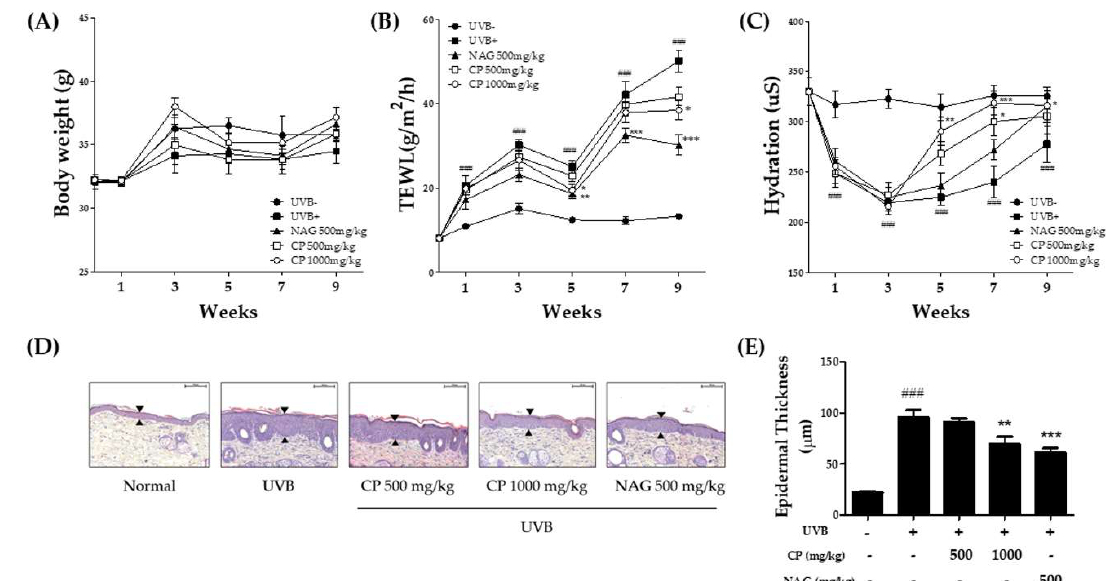
Figure 1. Effect of oral administration of collagen peptide on TEWL, hydration, and epidermal thickness in the dorsal skin of UVB-irradiated hairless mice. ( A ) Body weight changes, ( B ) TEWL, and ( C ) stratum corneum water content after repeated irradiation with UVB were measured using the Derma Combo System; ( D ) hematoxylin and eosin staining. Scale bar = 100 µ m. Arrows indicate the thickness of epidermis; ( E ) histogram of hematoxylin and eosin staining. The values are shown as mean ± SEM ( n = 8). ### p < 0.001 (vs. control mice). * p < 0.05, ** p < 0.01, and *** p < 0.001 (vs. UVB-irradiated mice).